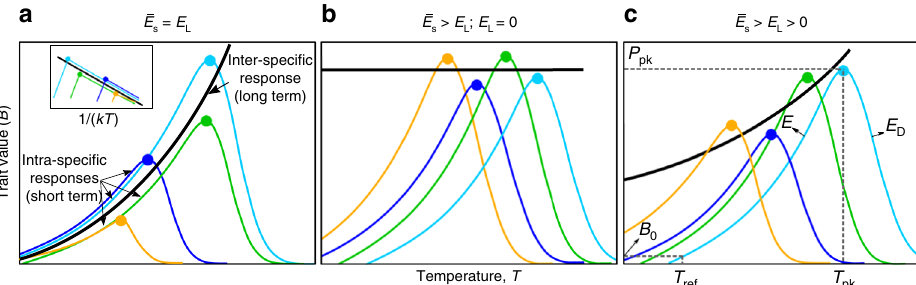
Fig. 1 Three alternative hypotheses for short- vs. long-term thermal responses. a Hotter-is-Better: organisms adapt around a global, inter-speci fi c, thermal constraint (black line, Boltzmann – Arrhenius fi tted to intra-speci fi c curve peaks), such that the average intra-speci fi c (short-term) activation energy ( E statistically indistinguishable from the inter-speci fi c (long-term) activation energy of the group of organisms ( E L ), and both are greater than zero. See the Methods section for more details on the the de fi nition and estimation of E that each intra-speci fi c TPC represents the short-term thermal response of each organism ’ s population. Inset panel illustrates how this would look in an Arrhenius plot. b Equalisation of fi tness: selection overrides thermodynamic constraints, such that trait performance at T ( E L ¼ 0). Alternatively, the same effect of E L ¼ 0 may occur due to or thermodynamic constraints on enzymes in fact restricting metabolic rate (and therefore fi tness) at higher temperatures. c Weak biochemical adaptation: an intermediate scenario where E illustrates the the Sharpe – School fi eld TPC model parameters (Eq. (1),